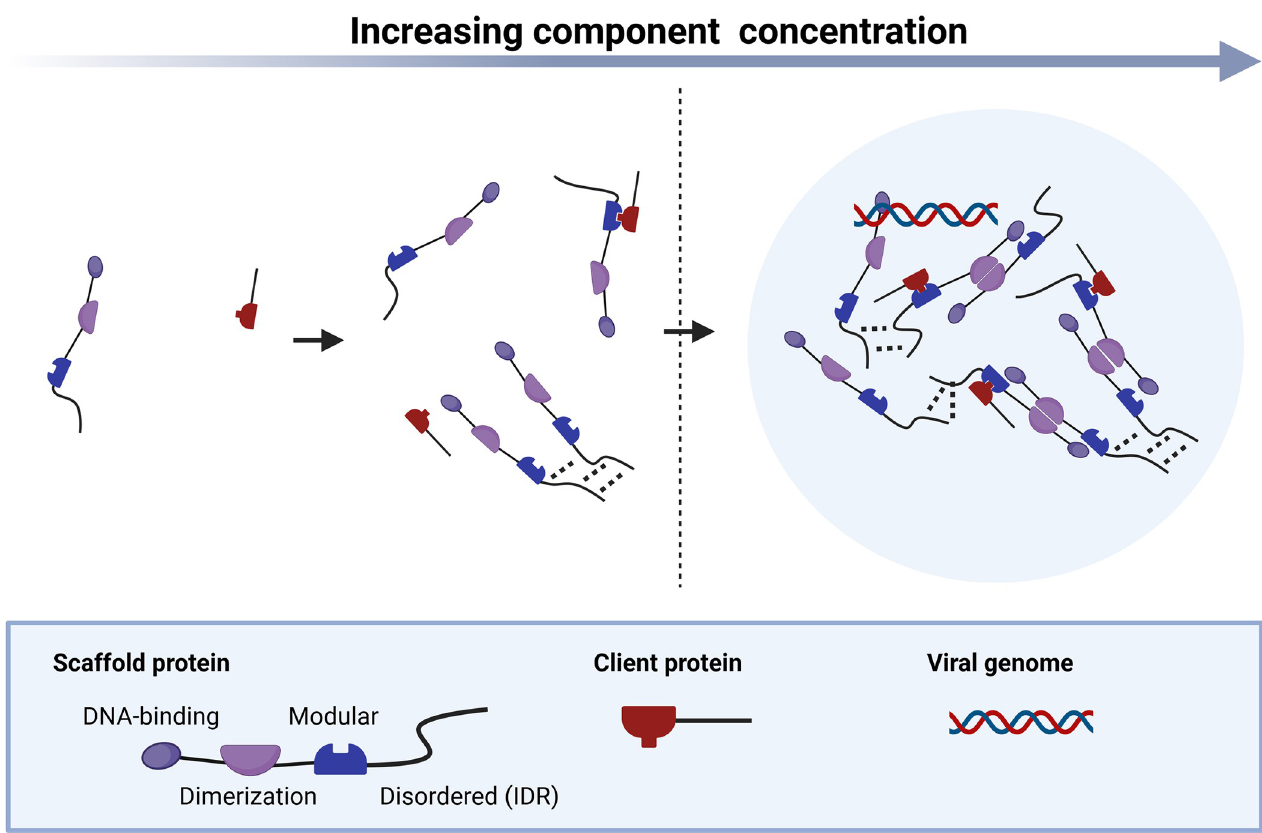
Fig 1. Interaction AU : AbbreviationlistshavebeencompiledforthoseusedinFigs 1 and 2 : Pleaseverifythatallentriesarecorrect : of multivalent molecules leading to LLPS. At constant environmental conditions (e.g., temperature, ionic strength, pH), the propensity of a multivalent scaffold protein to undergo LLPS only depends on its concentration. Crossing the protein’s specific concentration threshold (dashed line) leads to droplet formation resulting in a qualitative change upon a small, linear quantitative change. Created with Biorender.com. LLPS, liquid–liquid phase